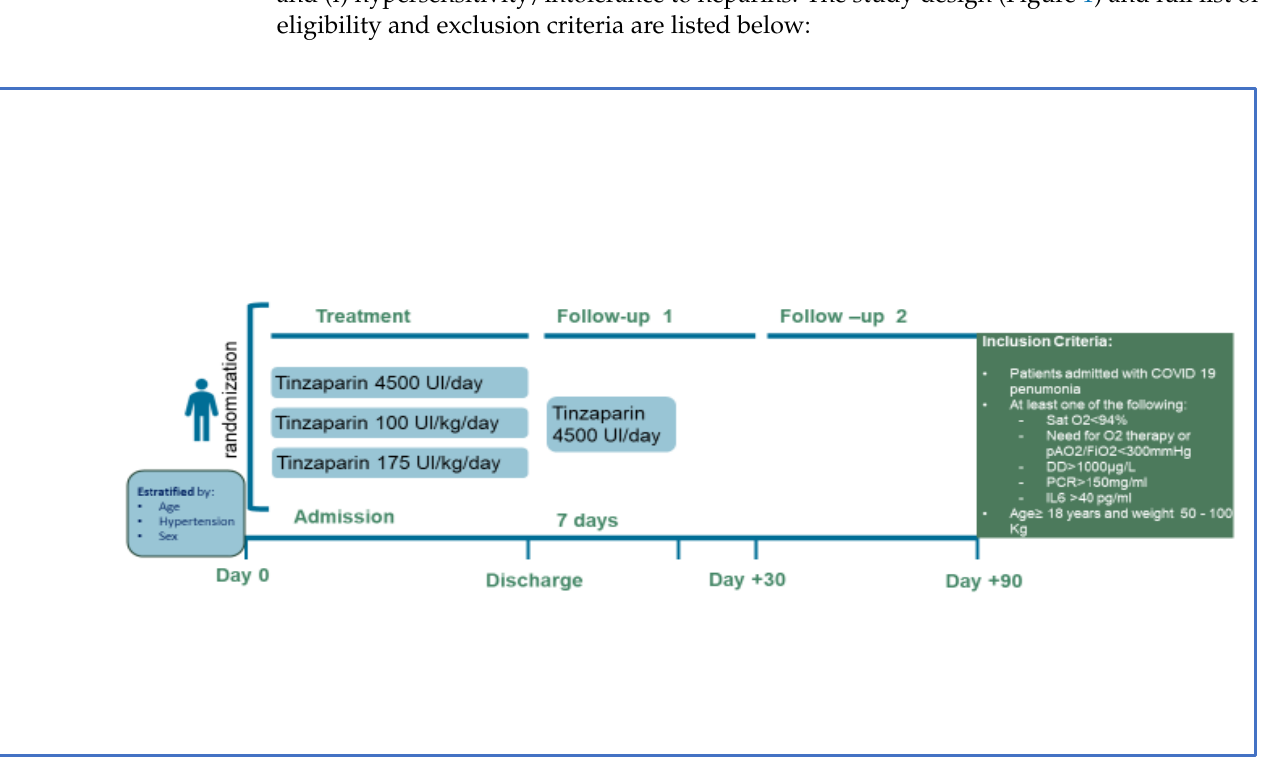
Figure 1. PROTHROMCOVID trial design.